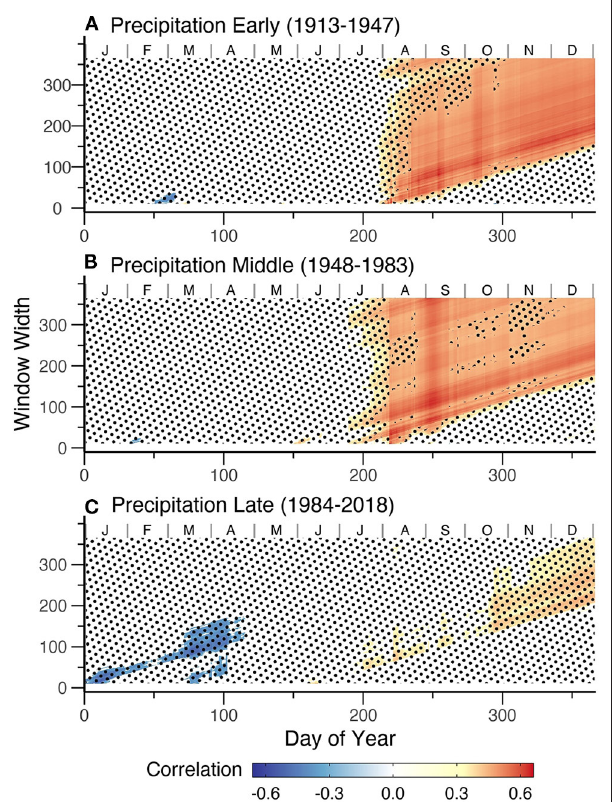
FIGURE 2 | Heat maps from the daily_response() function (Jevšenak and Levani ˇ c, 2018 ) illustrate correlations between the ISP latewood chronology and weekly to annual scale precipitation sums for three non-overlapping subperiods (A–C) . Correlations are calculated in relation to the ending day of the window (e.g., the correlation coefficient between latewood and total precipitation from DOY 10 to DOY 50 is plotted on DOY 50). Only correlations with p -values < 0.05 are shown. Black dots indicate that the correlation does not pass the significance threshold after correcting p -values for test multiplicity.